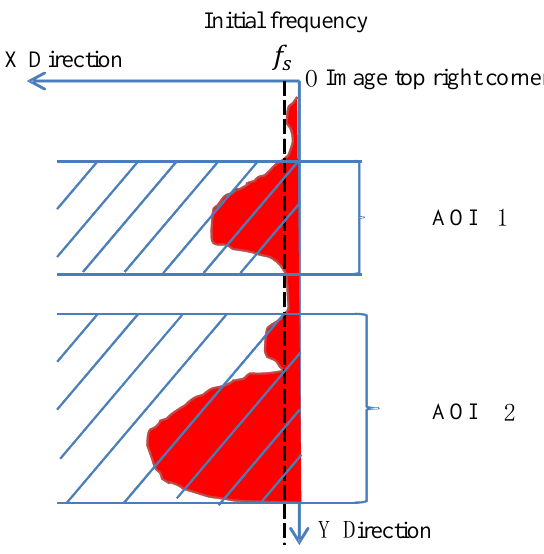
Figure 4. Sketch map of obtaining AOI via high-pass filtering As demonstrated by the projective statistical curve, if crossing exists in an image, an obvious peak will appear in y range where the crossing locates. Based on high-pass filtering, we set up a rather small initial frequency 𝑓 𝑠 , and set value y area higher than 𝑓 𝑠 as Area of Interest (AOI), as shown in Figure 4. In this way, irrelevant recognition results with low frequency of recurrence